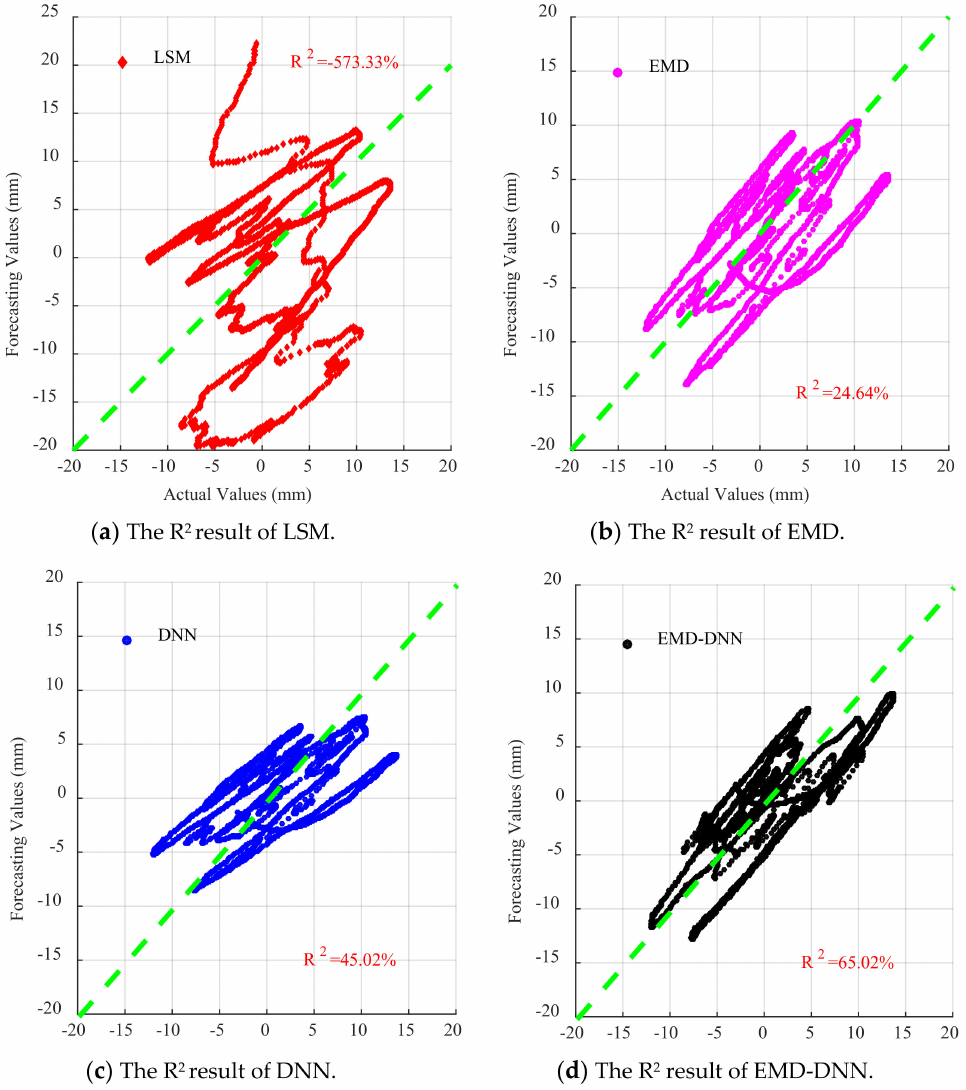
Figure 18. Scatter diagram of different correction methods for Taft